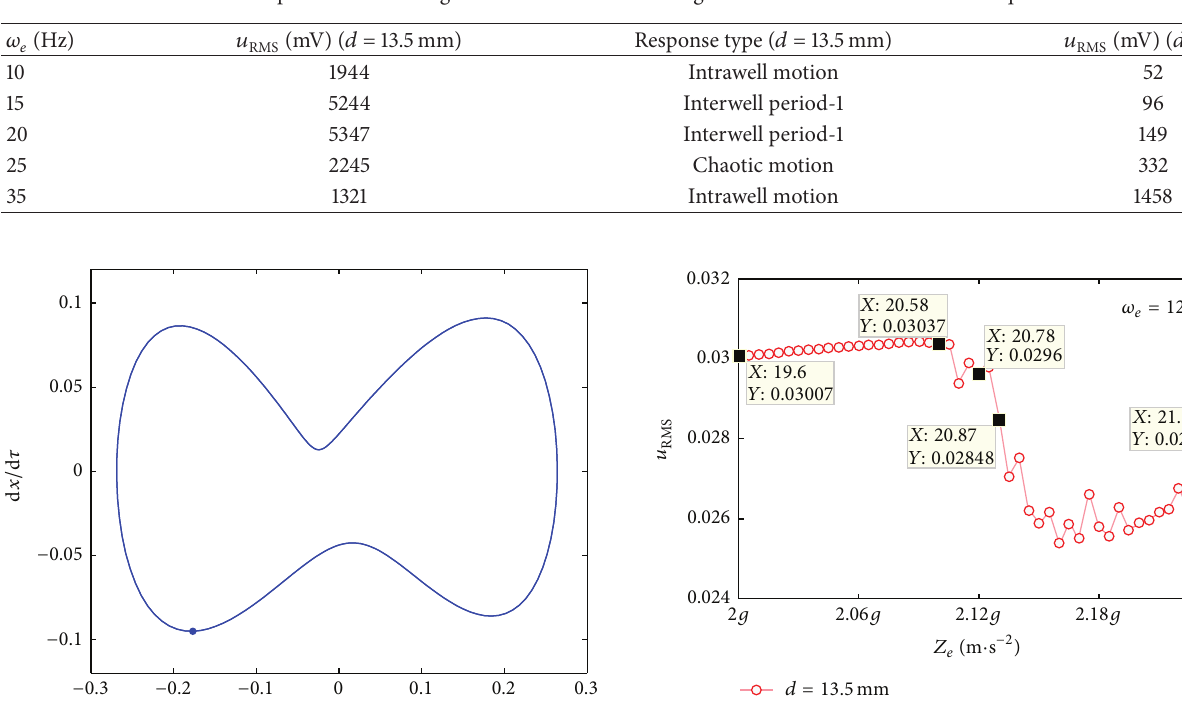
Figure 11: (a) Bifurcation diagram for increasing 𝑍 𝑒 with 𝜔 𝑒 = 12 Hz and (b) its locally enlarged portions for the range [2𝑔,2.1𝑔] . Table 3: Responses of bistable generator versus linear configuration for various excitations frequencies.